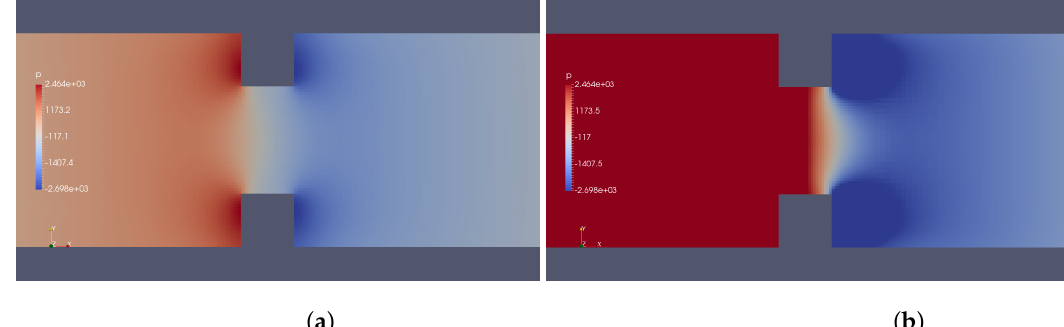
Figure 18. Pressure p . ( a ) ω ∗ = 0 and ( b ) ω ∗ = 6.0 × 10 − 3